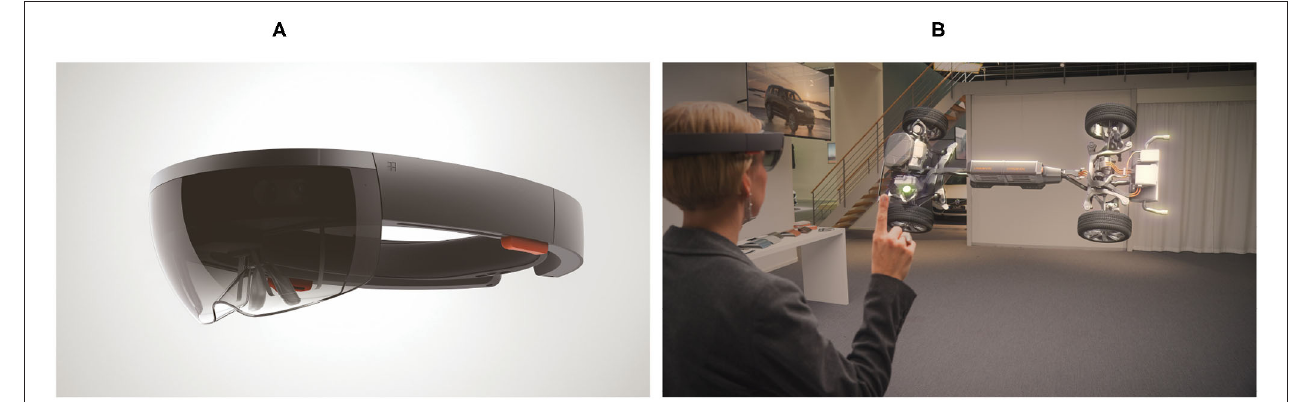
FIGURE 1 | The Microsoft HoloLens. (A) The Microsoft HoloLens device. (B) An example of a HoloLens application. In this case, the HoloLens device enables a human user to visualize and interact with a virtual three-dimensional object (Used with permission from